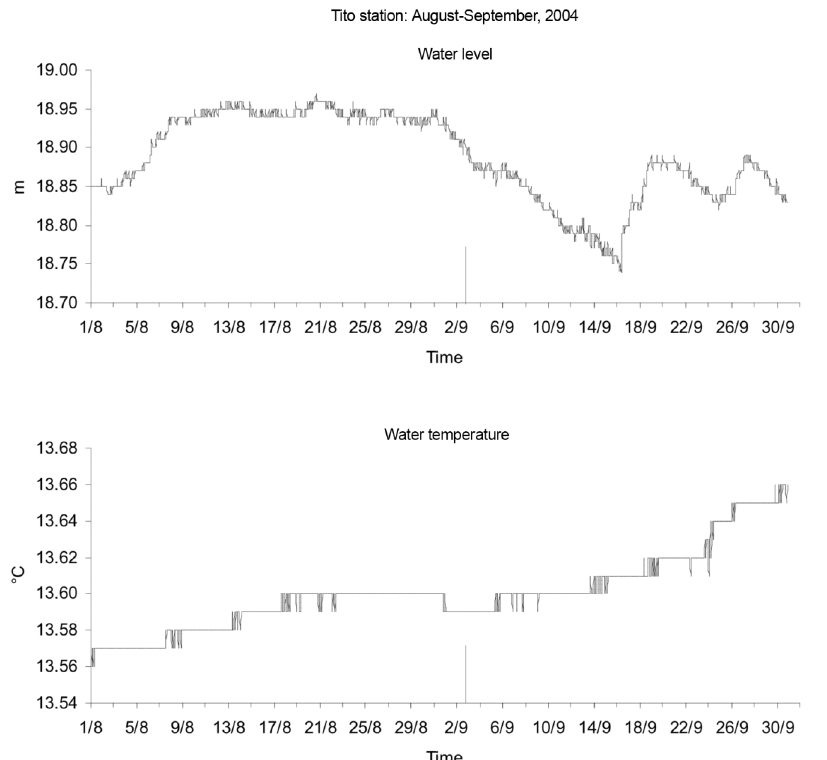
Fig. 8. Water level and water temperature recorded at the Tito station: August-September